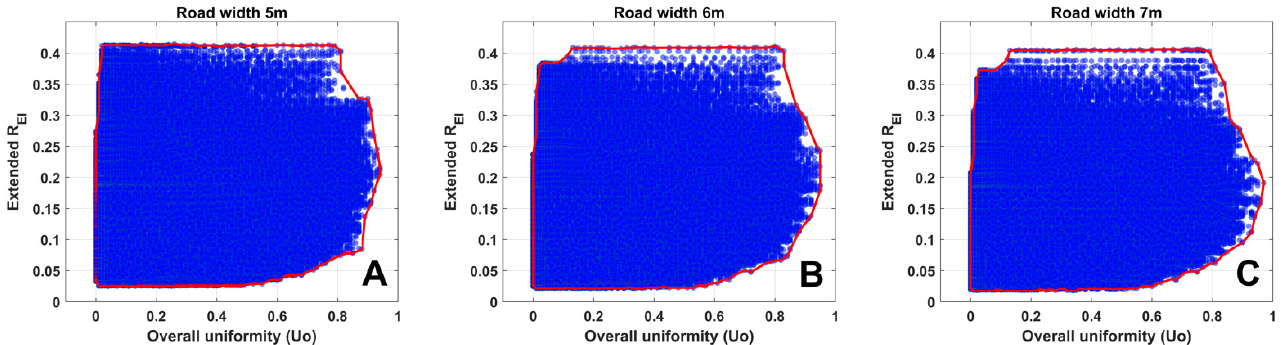
Figure 12. Uniformity vs. Extended R EI (up to 20 m left and right). Simulation results for all cases. The graphs include all potential pole arrangements, as shown in Table 1: ( A ) results for road width of 5 m; ( B ) results for road width of 6 m; ( C ) results for road width of 7 m.